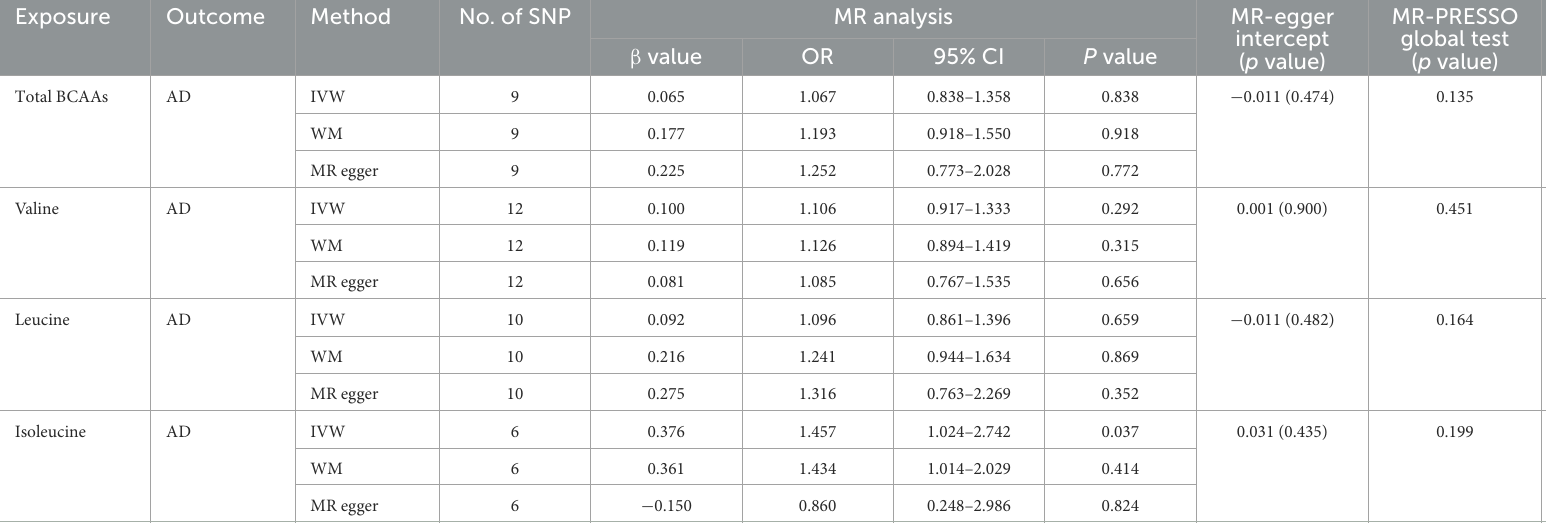
TABLE 1 Mendelian randomization analysis explore the genetic causal effects of the BCAAs on the risk of AD.